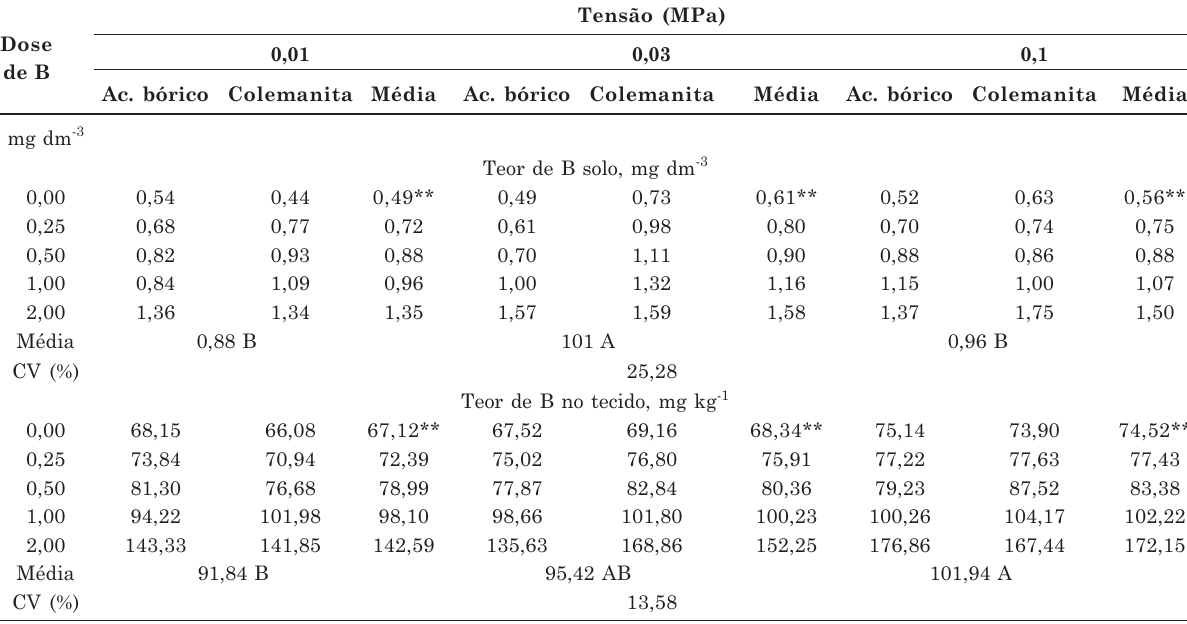
2. O teor de água no solo até a tensão de -0,1 MPa não foi fator limitante para a absorção de B pela cultura da soja, em Latossolo Vermelho eutroférrico de textura arenosa com nível adequado desse nutriente.